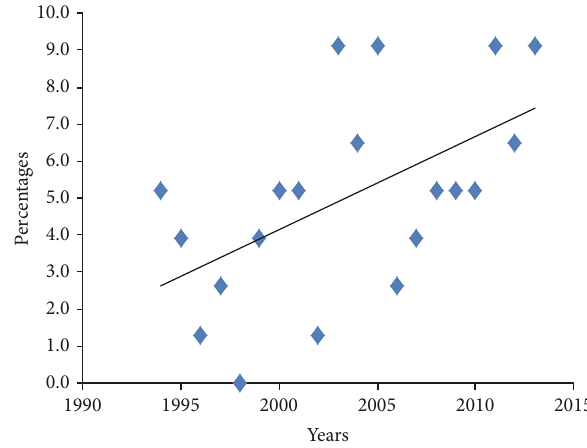
Figure 1: Annual Trend in FTC for the period 1994–2013.